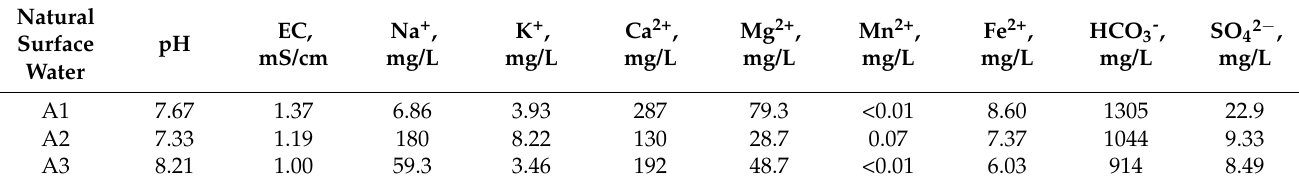
Table 1. Characterization of natural surface